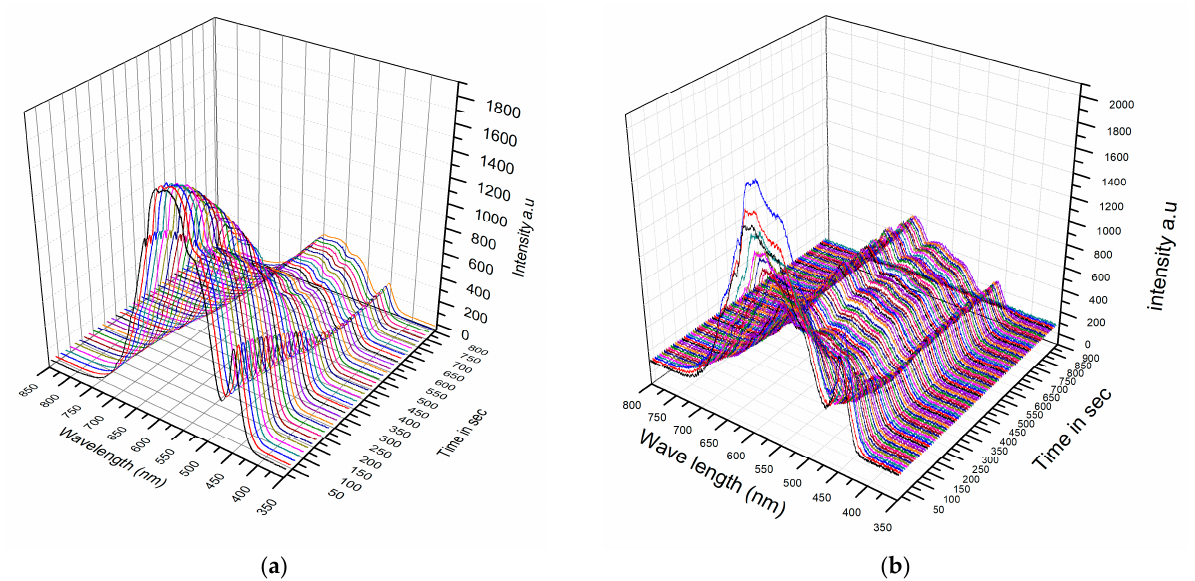
Figure 5. ( a ) Ex vivo porcine spectral measurements taken during thawing. ( b ) In vivo human finger spectral measurements taken during thawing. spectral measurements taken during